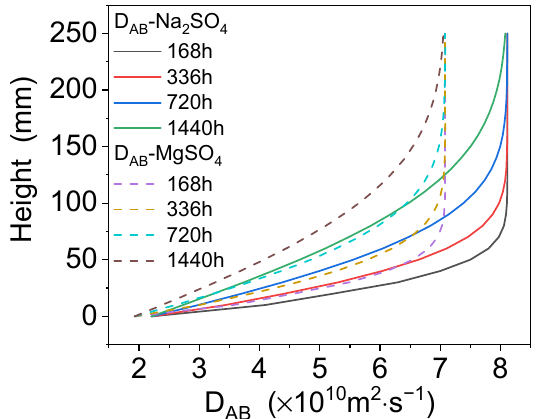
Figure 8. Calculated local mass transfer coefficient profiles at different times in the dissolution and diffusion processes of bloedite.